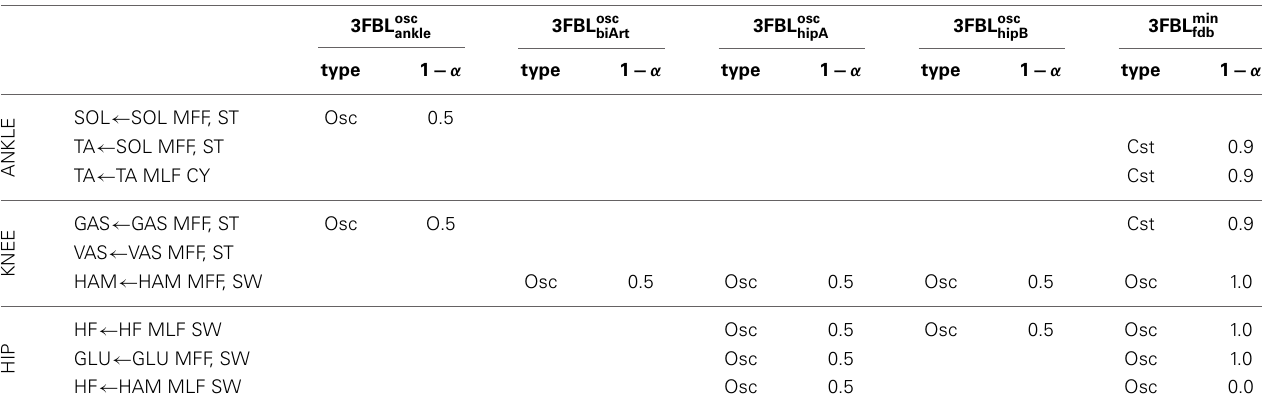
Table 3 | Description of the CPG-FDB combination map for the 5 different 3FBL